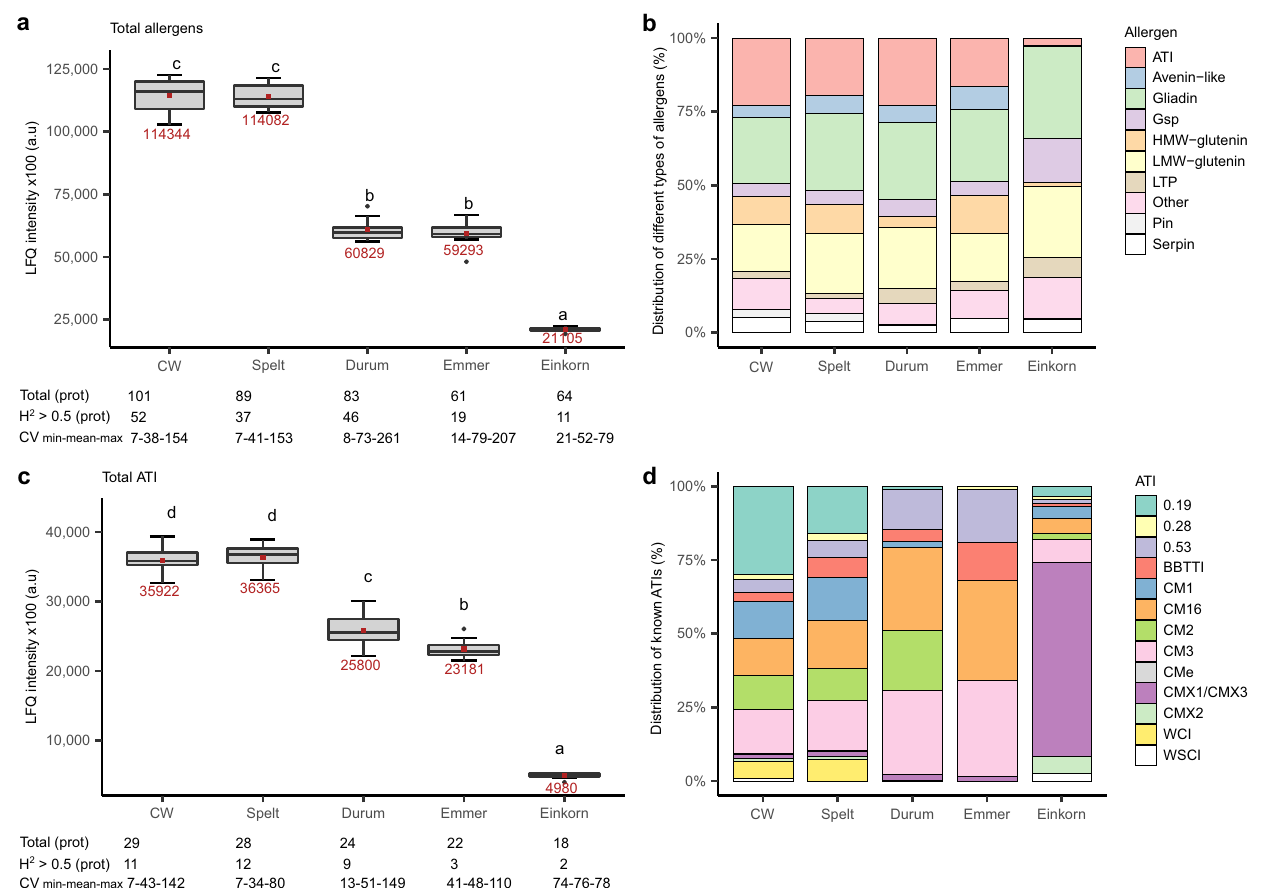
Fig. 4 Allergenic proteins in wheat species. LFQ intensity/abundance of different families of proteins per cultivar in different wheat species for ( a ) potential allergens, and ( c ) proteins identi fi ed as ATIs. Boxes with different letters indicate signi fi cant differences between the wheat species (ANOVA with Tukey ’ s test, p < 0.05). Each box summarizes the content of 30 samples (ten cultivars grown at three locations). Mean values for each species are highlighted in red color. Furthermore, within each species the distribution of ( b ) allergens, and ( d ) ATIs with a known type is shown. CW, common wheat; Total (prot), number of allergenic proteins or ATIs used to calculate total LFQ intensity (%); H 2 > 0.5 (prot), number of allergenic proteins or ATIs with heritability >0.5; H 2 , heritability; CV min-mean-max , minimum-mean-maximum values of the coef fi cient of variation (%) for allergenic proteins or ATIs with heritability >0.5; LFQ, label-free quanti fi cation; ATI, amylase/trypsin inhibitor; Gsp, grain softness protein; HMW, high molecular weight; LMW, low molecular weight; LTP, lipid transfer protein; Pin, puroindoline; BBTTI, Bowman-Birk type trypsin inhibitor; CM, chloroform/methanol soluble protein; WCI, wheat chymotrypsin inhibitor; WSCI, wheat subtilisin- chymotrypsin